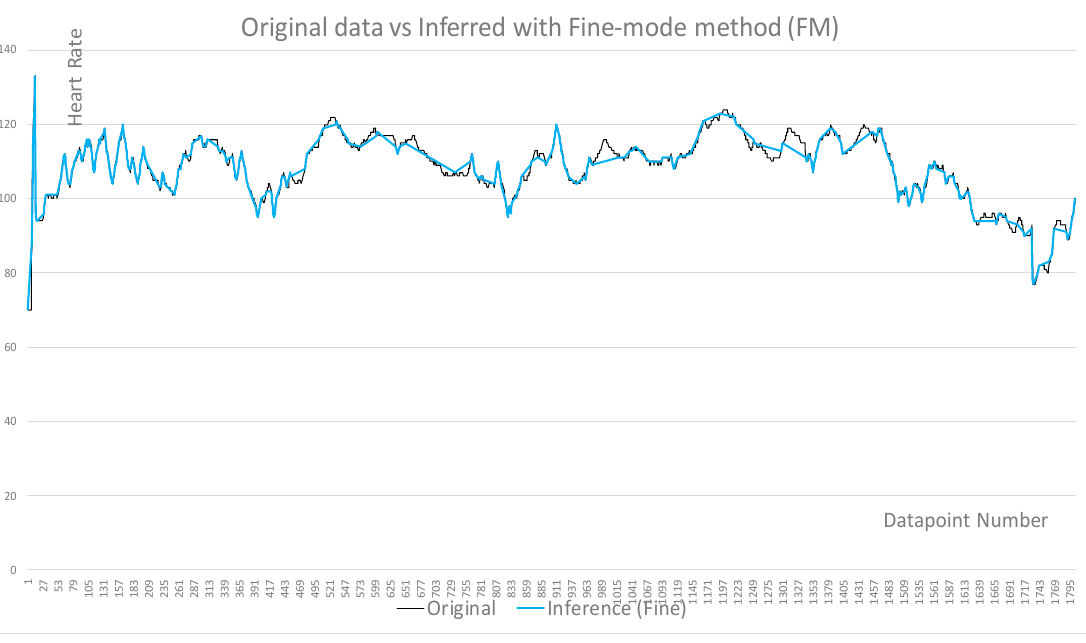
Figure 5. Original data points versus Fine-mode method (FM) applied for inference (original DP: 1800, inferred DP: 449).